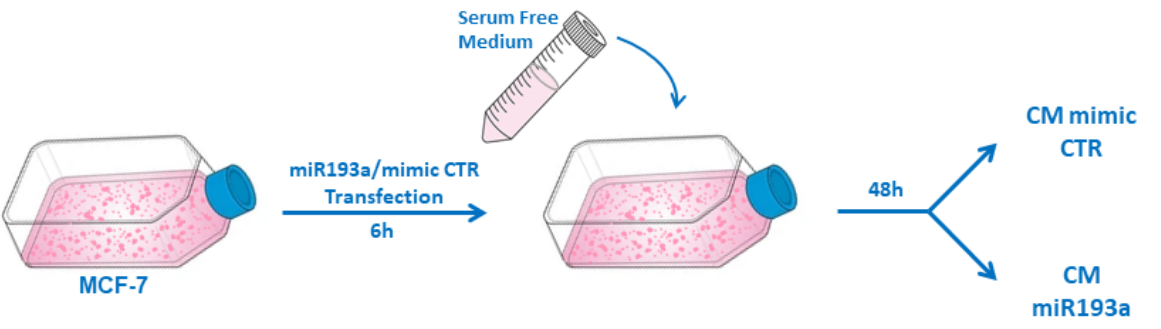
Figure 1. Schematic representation of conditioned serum-free media (CM) formation and collection. MCF-7 cells grown in 75 cm 2 tissue culture flasks were transfected for 6 h with miR193a or mimic control (CTR). Subsequently, the transfection medium was replaced with the serum-free medium. After 48 h, CM from mimic CTR and miR193a treated cells were collected, centrifuged, and filtered through 0.2 μ syringe filters.